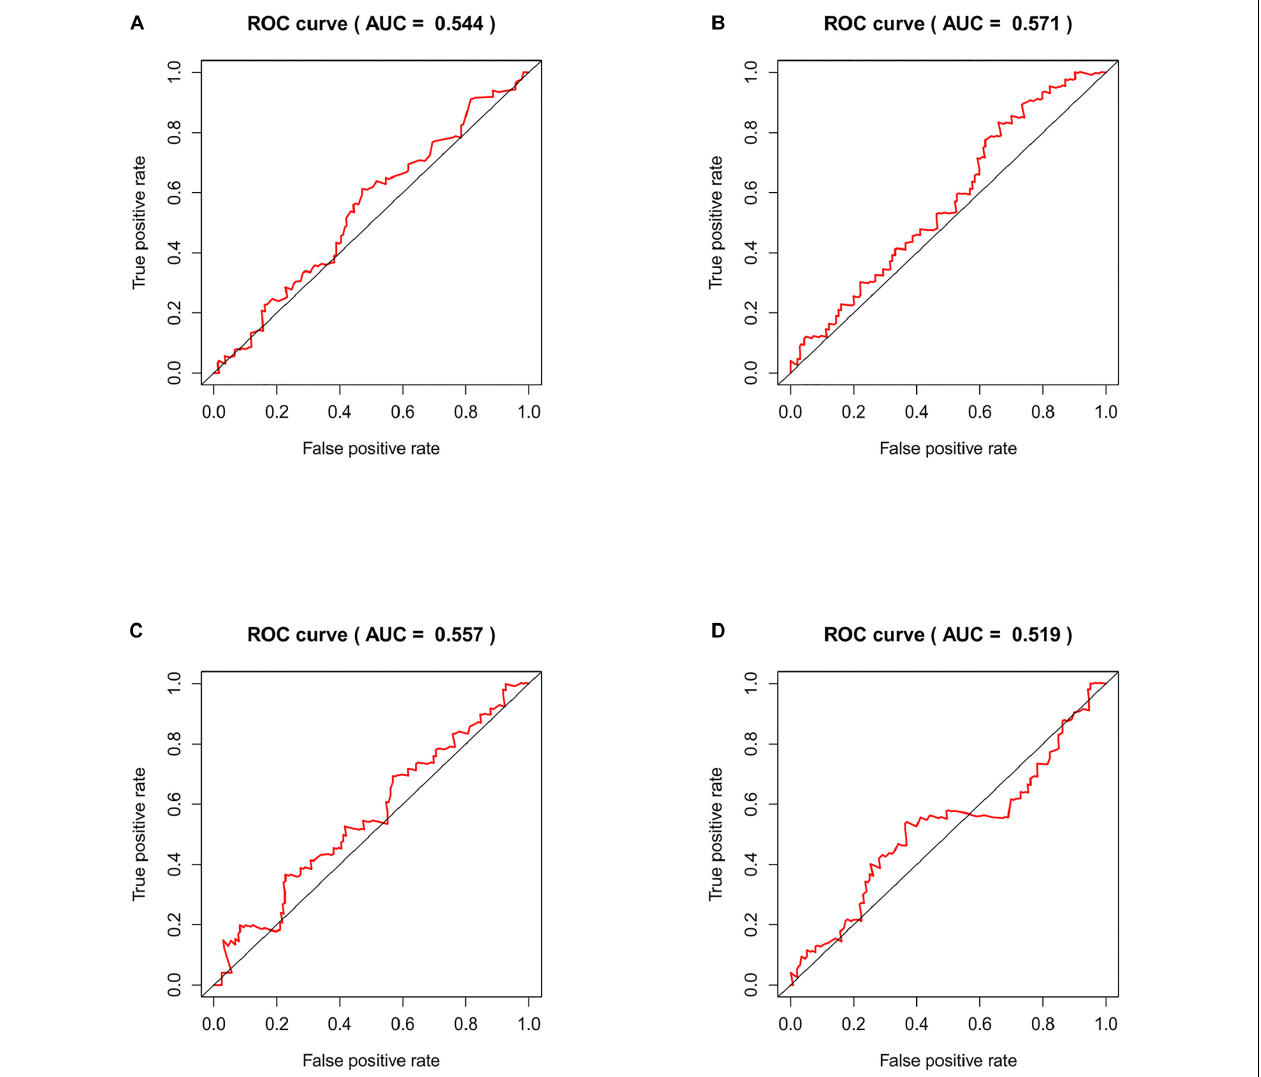
FIGURE 9 | Time-ROC curve analysis of risk model in the independent validation dataset. (A) The AUC of ROC of 5 years about Immune-related lncRNA signature in the independent validation dataset. (B) The AUC of ROC of 5 years about Six-lncRNA signature (PMID 33324975) in the independent validation dataset. (C) The AUC of ROC of 5 years about seven-lncRNA signature (PMID 32596372) in the independent validation dataset. (D) The AUC of ROC of 5 years about seven-lncRNA signature (PMID 33163400) in the independent validation